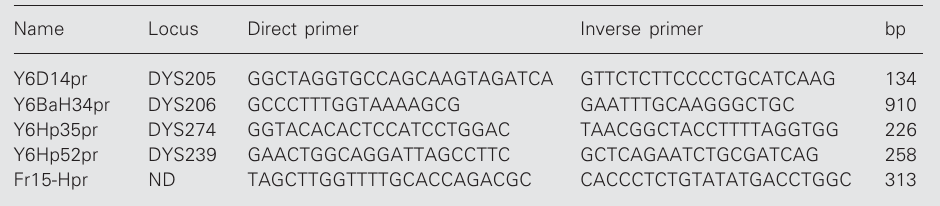
Table 1. Primers used in multiplex